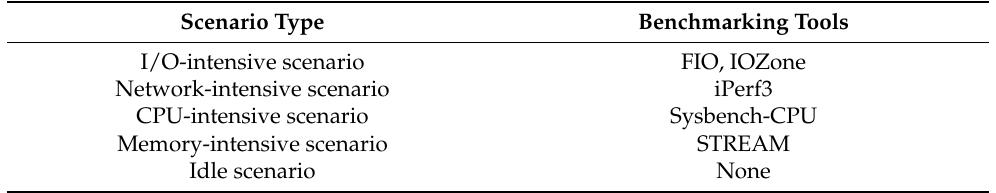
Table 1. Scenario simulation